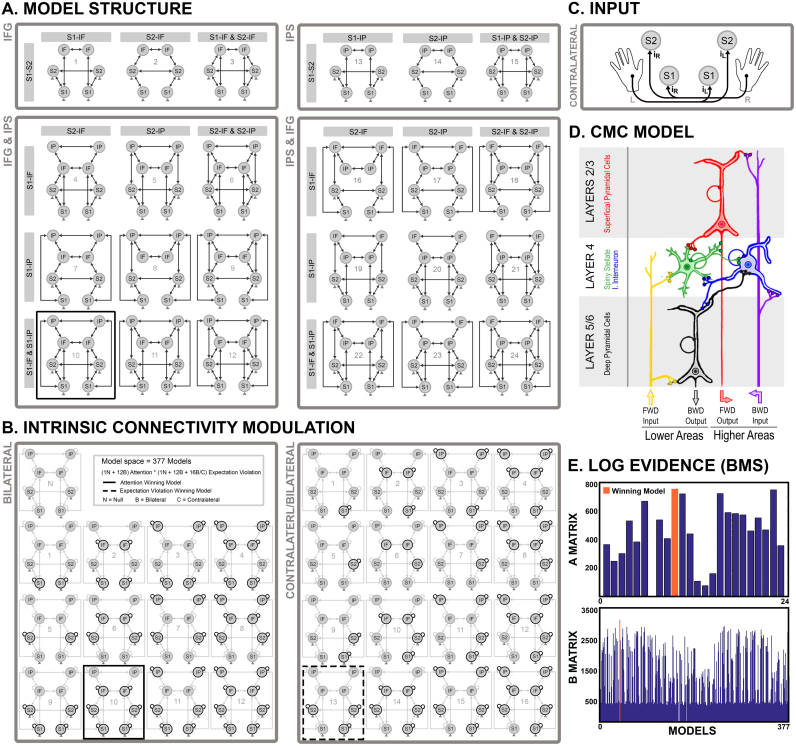
A) Architectures of 24 alternative models of somatosensory and fronto-parietal regions, fitted to grand-averaged ERF data. The models differed with respect to the inclusion of a frontal (IFG) and/or parietal (IPC) node, as well as the hierarchical architecture and connections between somatosensory and fronto-parietal areas. B) Contextual modulations of intrinsic connectivity by attention and expectation violation were optimized with respect to 1 null model, 12 bilateral alternative models (attention and expectation violation) and 16 contralateral somatosensory models (expectation violation). In the figure, the contralateral models are shown for left expectation violation. Right expectation violation models were identical but with left lateralization of somatosensory regions. C) Both contralateral S1 and S2 were specified as cortical targets of thalamic input. D) All DCMs were tested using a canonical microcircuit model. Each source was thus modeled as compromising 4 neuronal populations (superficial and deep pyramidal cells, spiny stellate and inhibitory interneurons). E) The winning model structure (M10), identified using fixed-effect Bayesian model selection, included all bilateral regions, with IPC at the highest hierarchical level, as well as connections between S1 to both fronto-parietal nodes and connections between S2 and the frontal node. E) The winning model of connectivity modulation, identified using fixed-effect Bayesian model selection, included changes in gain in bilateral primary, secondary somatosensory cortex, as well as and IFG by attention (M10). Further, the winning model revealed changes in contralateral primary and bilateral secondary somatosensory cortex by expectation violation (M13).